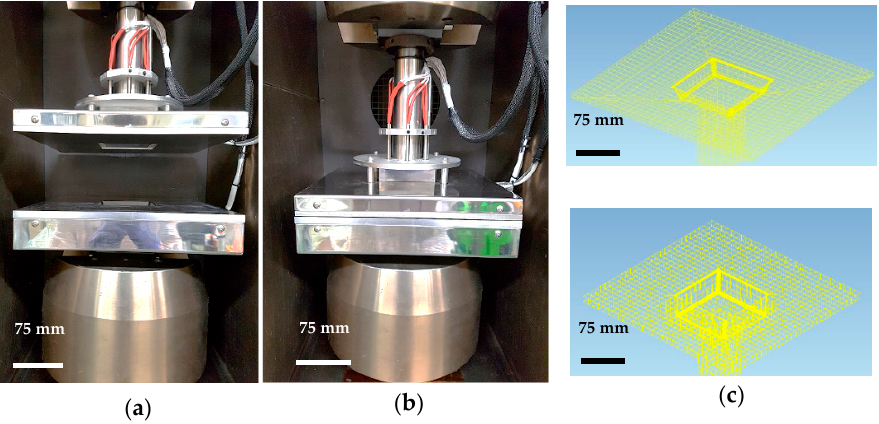
Figure 2. Thermoforming experimental apparatus for ( a ) open, ( b ) closed square-cup mold, ( c ) Type 1 with a 20 mm mold thickness and 110° draft angle ( top ) Type 2 with a 40 mm mold thickness and 90° draft angle ( bottom ).